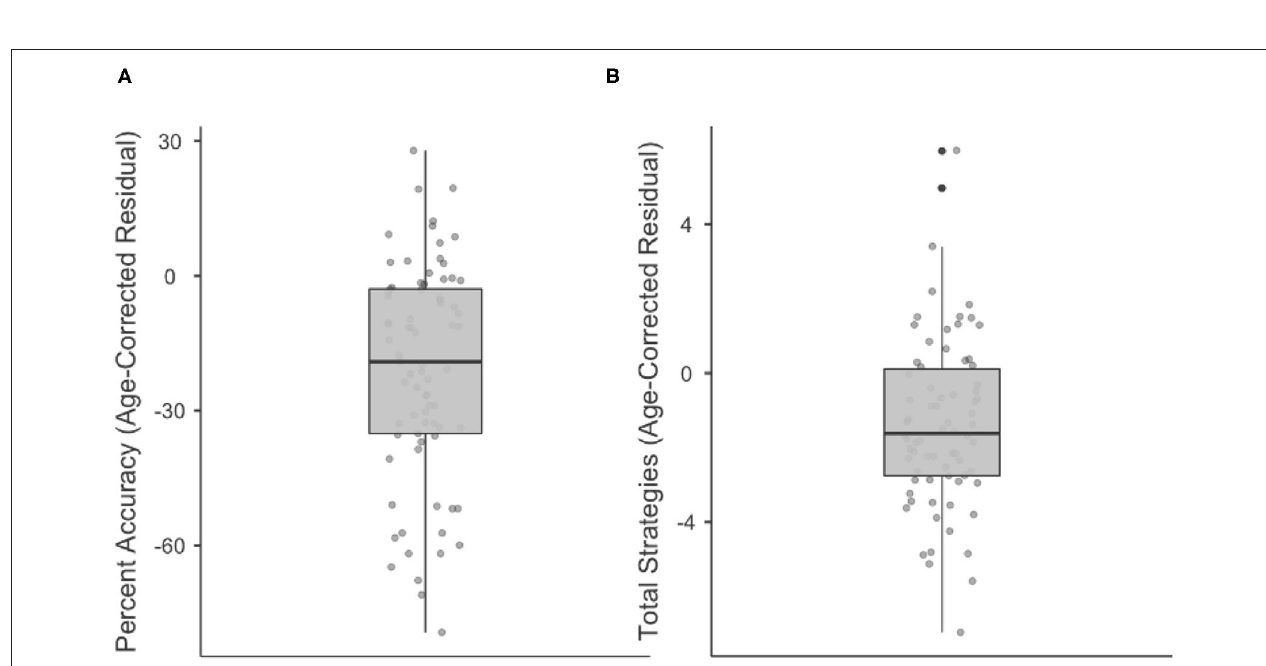
FIGURE 3 | Boxplots showing median, interquartile range, range, and individual datapoints of stroke patient residual scores (raw score—age-predicted score) for percent accuracy (A) and total strategies (B) . Median/interquartile range of residual scores are below age predictions.